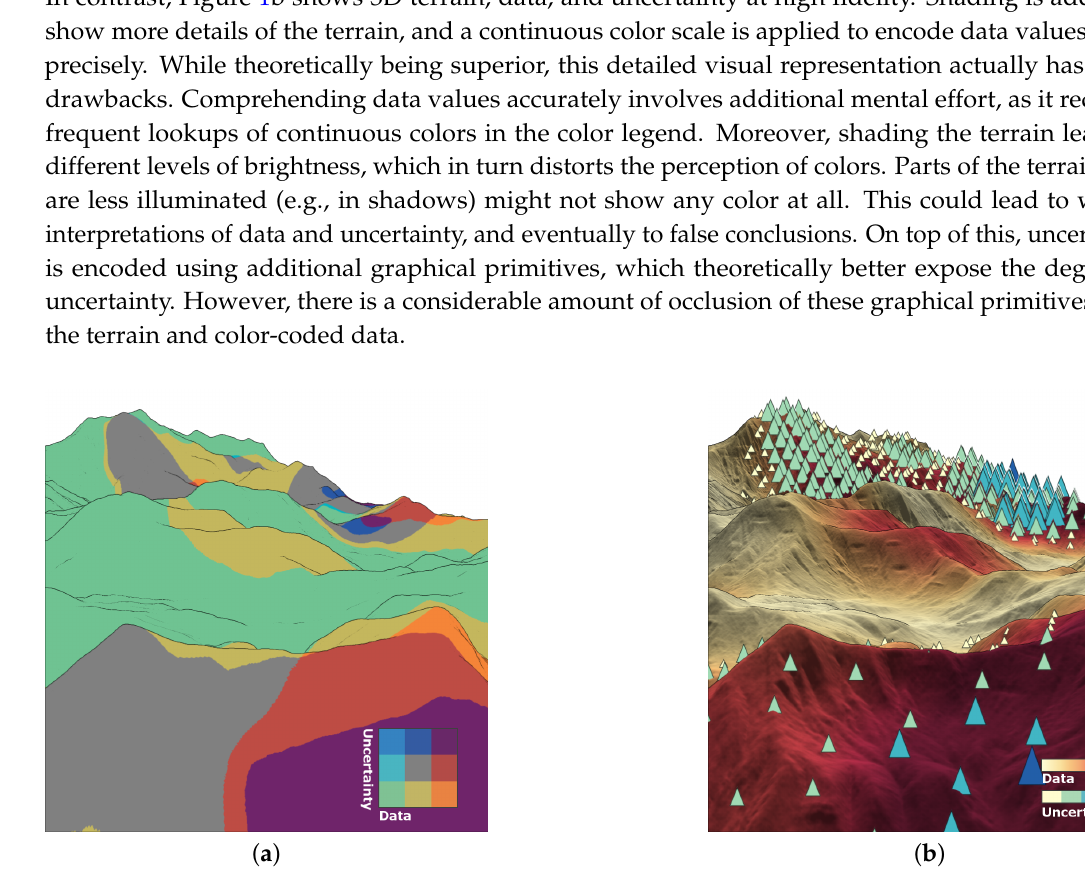
Figure 1. Visualization of 3D terrain, wind speed forecast data, and forecast uncertainty. ( a ) The terrain is depicted abstractly using contour lines, and a bivariate color scale with few discrete colors is used to encode the data (green to red) and the uncertainty (green to blue); ( b ) The terrain is depicted faithfully by shading its surface, a continuous color scale (yellow to red) is used for the data, and uncertainty is represented by color-coded (yellow to blue) triangular